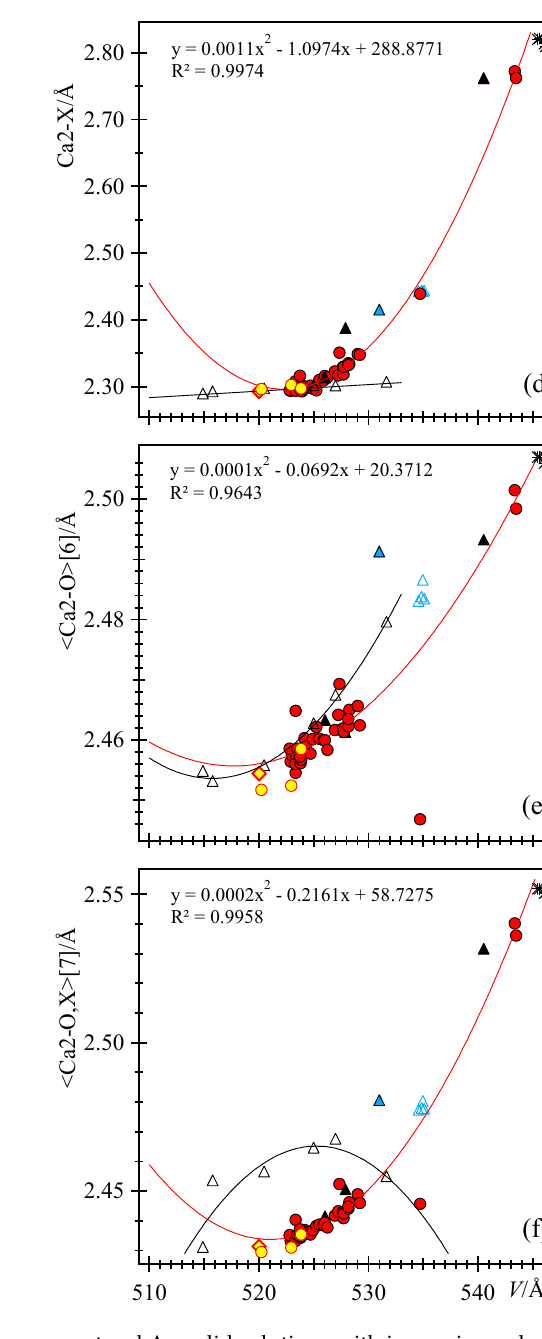
Figure 12. Structural variations across natural Ap solid solutions with increasing volume, V : ( a ) the average <P-O>[4] distance is nearly constant; ( b ) the average <O-P-O>[6] angle decreases slightly; ( c ) the average <Ca1-O>[9] distance increases and then decreases in a convex-up manner; ( d ) The Ca2-X distance; ( e ) average <Ca2-O>[6] distance, and more importantly, ( f ) the average <Ca2-O,X>[7] distance, which is the full coordination for the Ca2 site, increases non-linearly in a convex-down manner and has the highest R 2 correlation factor. Some average <O-P-O>[6] angles from the literature were calculated as these were not provided by some authors. All the red trend lines (equations inserted) are based on data only from this study. Group-1 synthetic binary-Ap samples (blue open triangles) from the literature are significantly off the red trend lines in ( a – c ), but are close to the red trend lines in ( d – f ). Group-4 samples (black open triangles) give rise to the black trend lines. Our data points for samples-1, -33, and minor phases -30b and -31b are not included in the red-trend line computation.